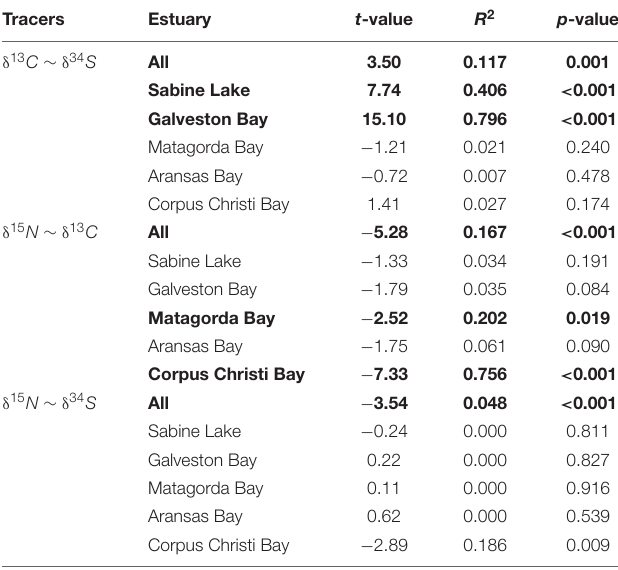
TABLE 4 | Pairwise robust regression results for stable isotopes from muscle tissue of juvenile bull sharks collected from nwGoM estuaries. Tracers Estuary t -value R 2 p -value δ 13 C ∼ δ 34 S 3.50 0.117 0.001 7.74 <